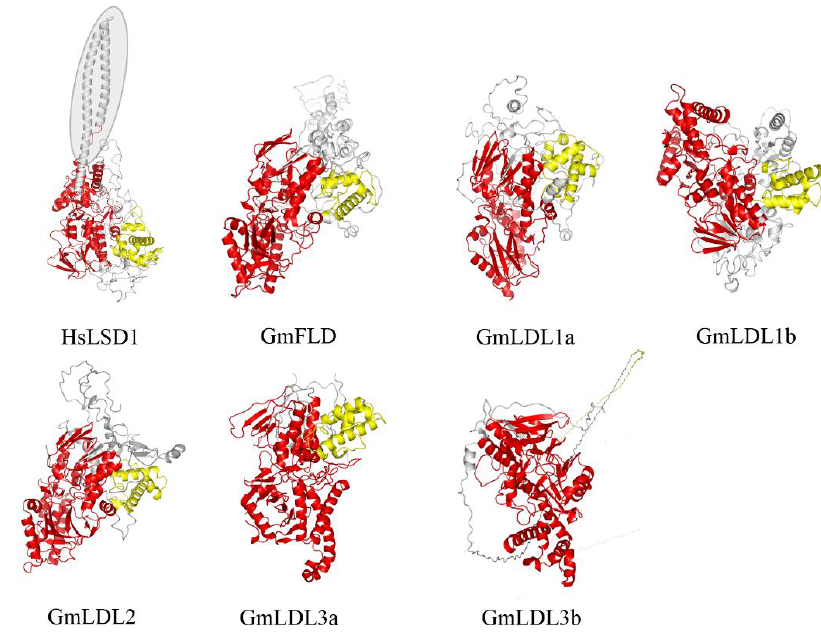
Figure 2. Three-dimensional structures of HsLSD1 and GmLDLs. The three-dimensional structure of human LSD1 (HsLSD1) is determined by Forneris et al. [32] in complex (substrate-like) peptide inhibitors. The three-dimensional structures of GmLDLs were obtained through molecular model- ing approaches using the intensive mode. The conserved domains, SWRIM and amino oxidase, are represented in yellow and red, respectively. The shade indicates the Tower domain. The GmLDL3a and GmLDL3b just show the structures of conserved domains.